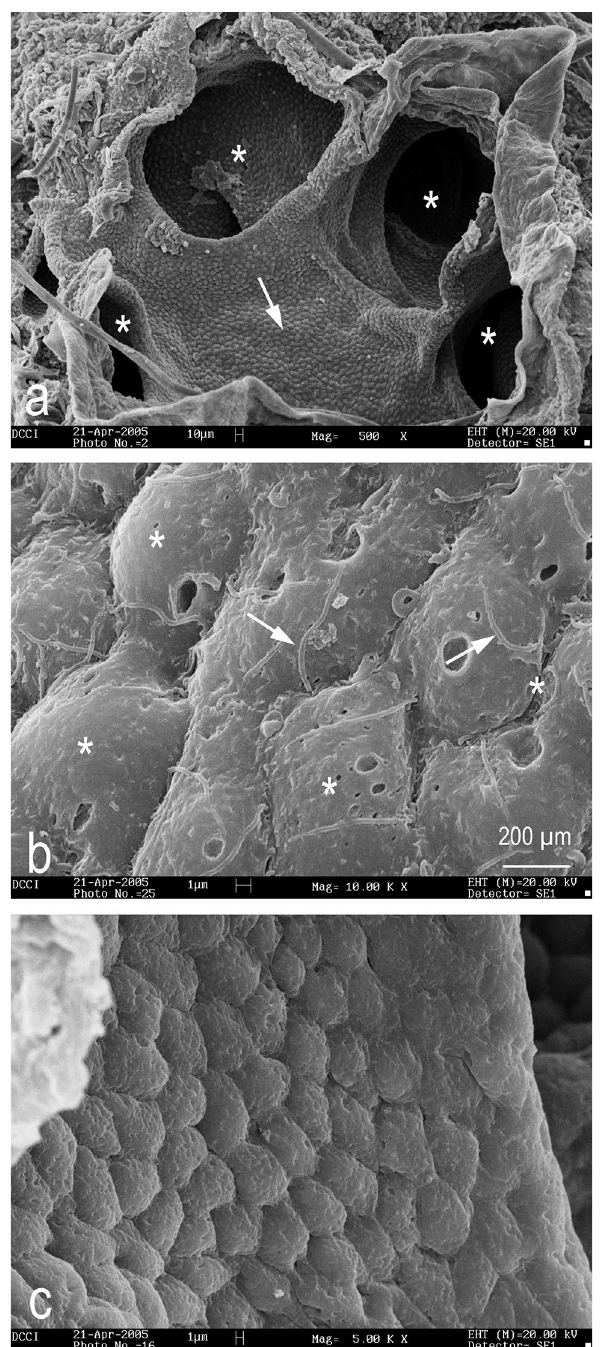
Figure 6. SEM micrograph of ampullary electroreceptors of C. monstrosa . ( a ) The chambers (asterisks) and a central plate (arrow) are visible; ( b ) the sensory epithelium in alveoli; ( c ) the epithelium covering the canal. Among the supporting cells (asterisks), the sensory cilia of the sensory cells are visible